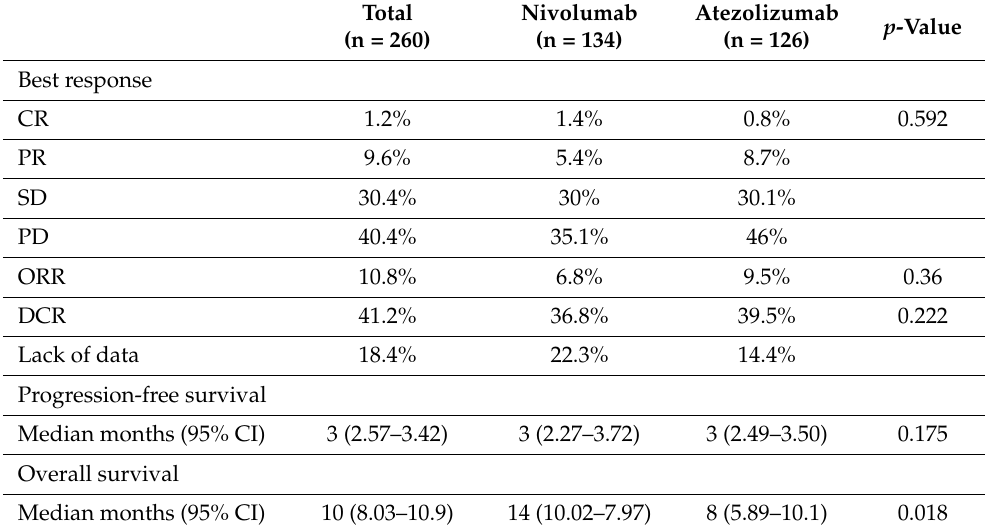
Table 3. Treatment outcomes in the general population and subgroups analysed (nivolumab vs. atezolizumab).